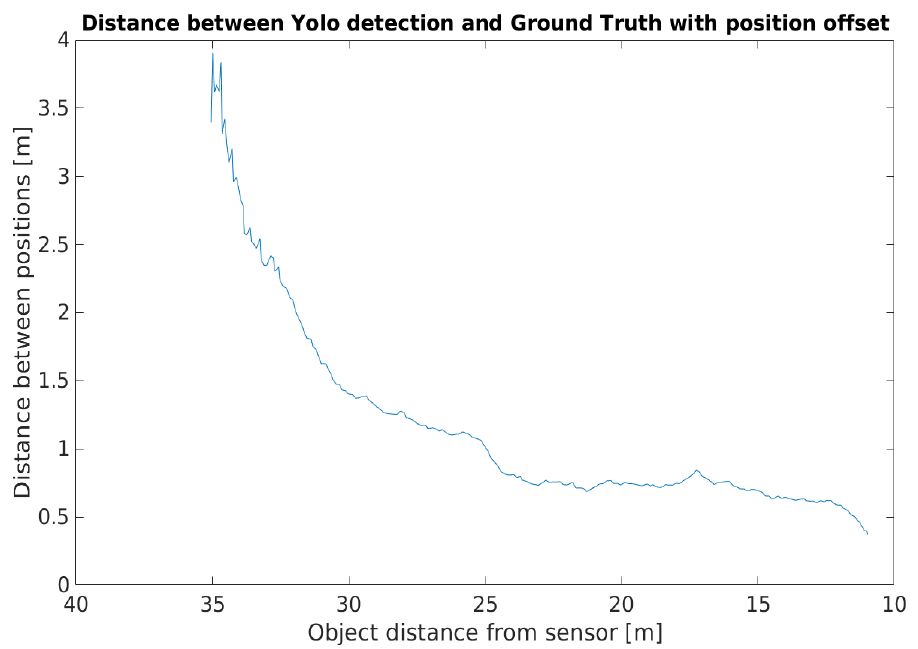
Figure 33. Position difference between ground truth and detection.